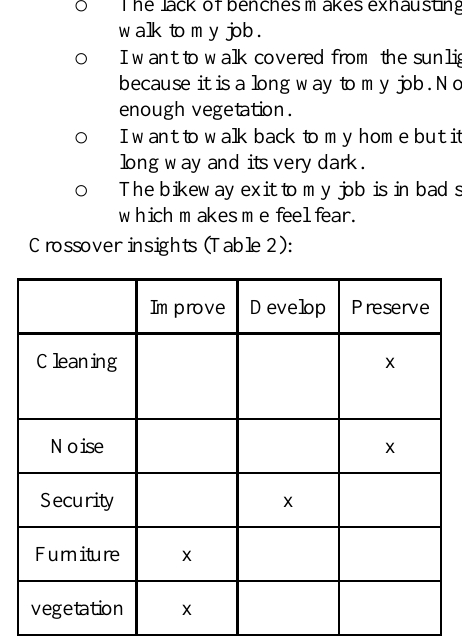
Table 2. Example of crossover insights